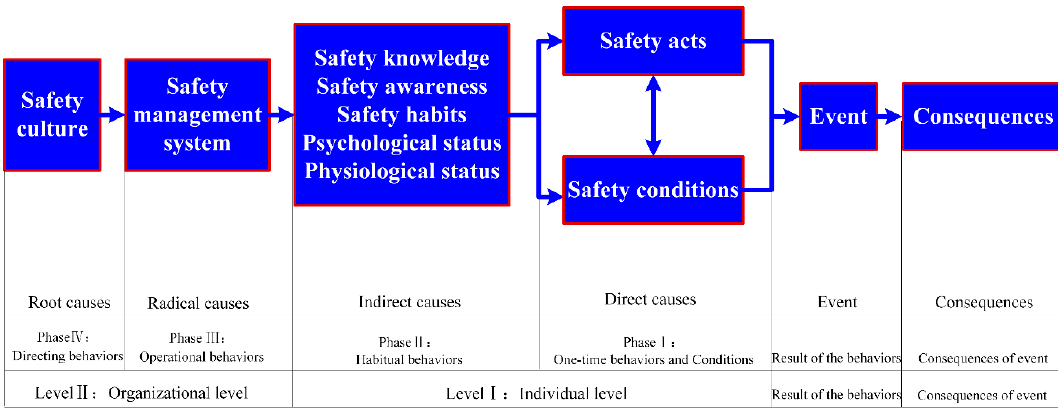
Figure 2. Behavior-based 24Model [33]. Reproduced with permission from [Fu, G.], [Studies on the Structure of Safety Science]; published by [Safety Science Publishing: Beijing, China], [2015].